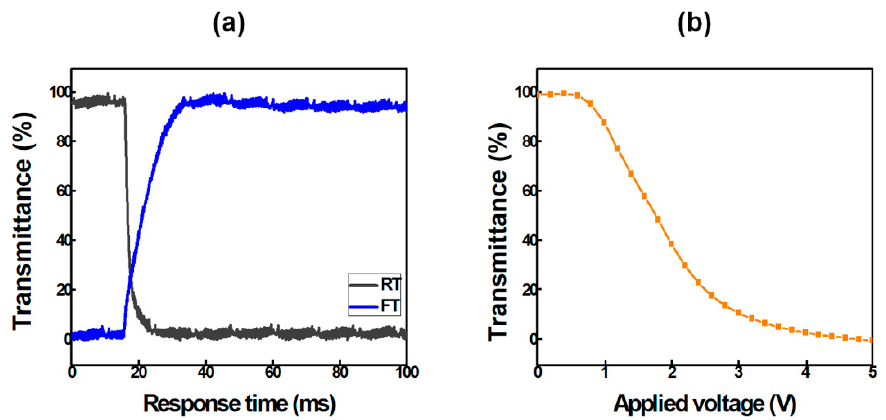
Figure 9. Investigation into electro-optical properties of twisted-nematic LC cell assembled from brush-coated nickel yttrium oxide films. ( a ) Response time and ( b ) threshold voltage.